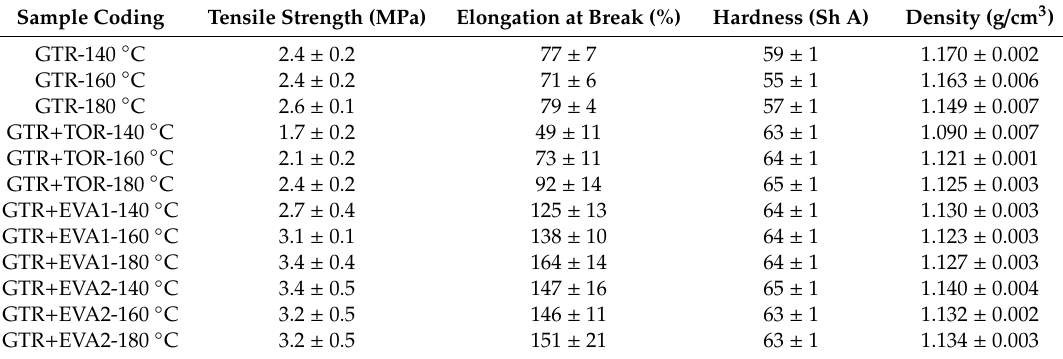
Table 6. Physico-mechanical properties of GTR and GTR modified by thermoplastics.